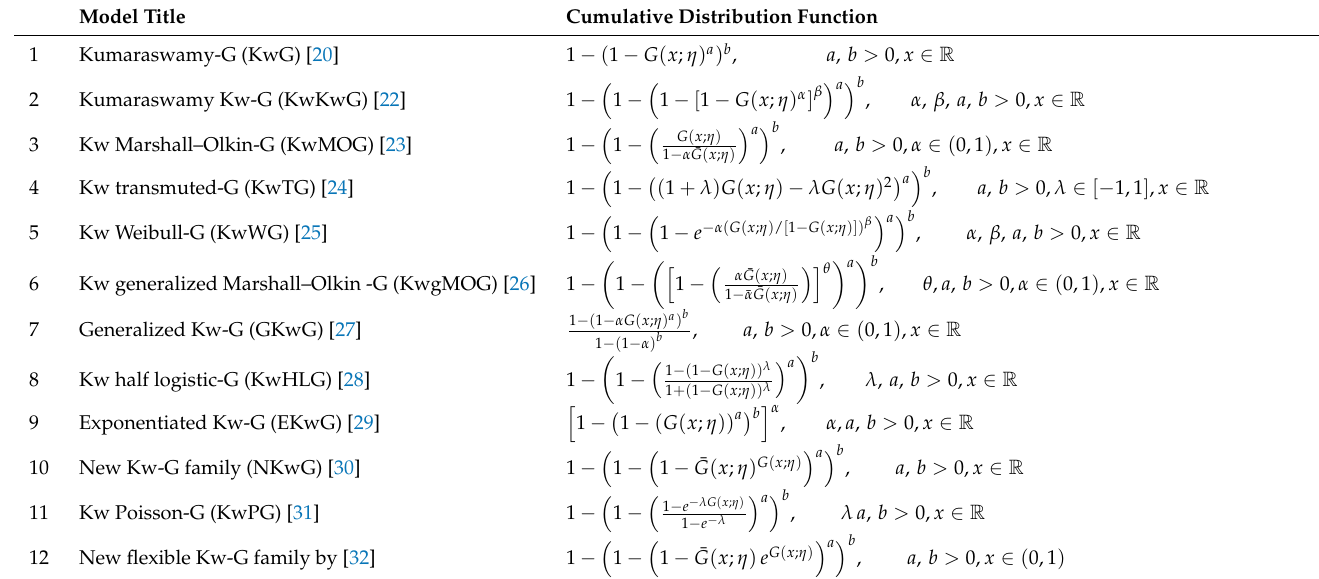
Table 1. Main Kw generated families of